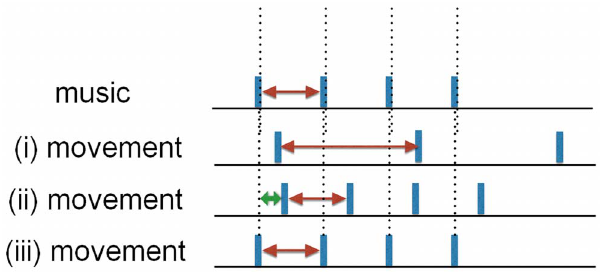
Fig. 2. Alignments between music and movement. Given the musical beat shown on top, the movement has (i) no period nor in-phase alignment, (ii) period alignment but no in-phase alignment, (iii) period and in- phase